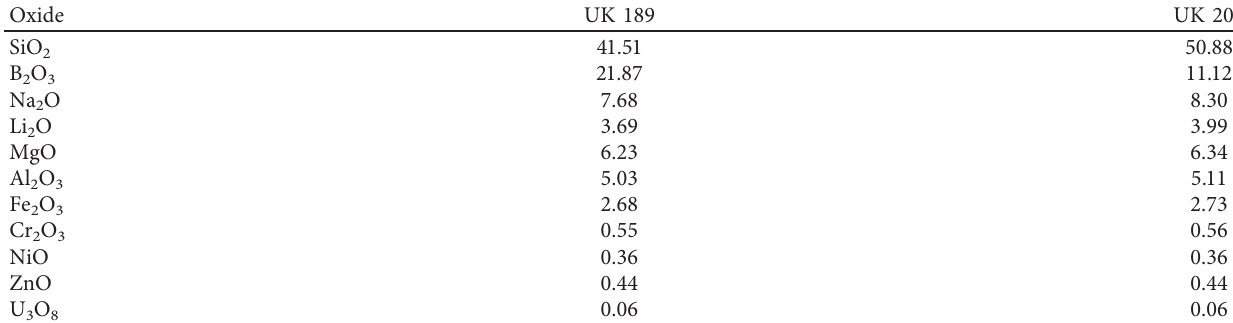
Table 6: The composition of borosilicate glasses, produced in UK, wt.% [52].